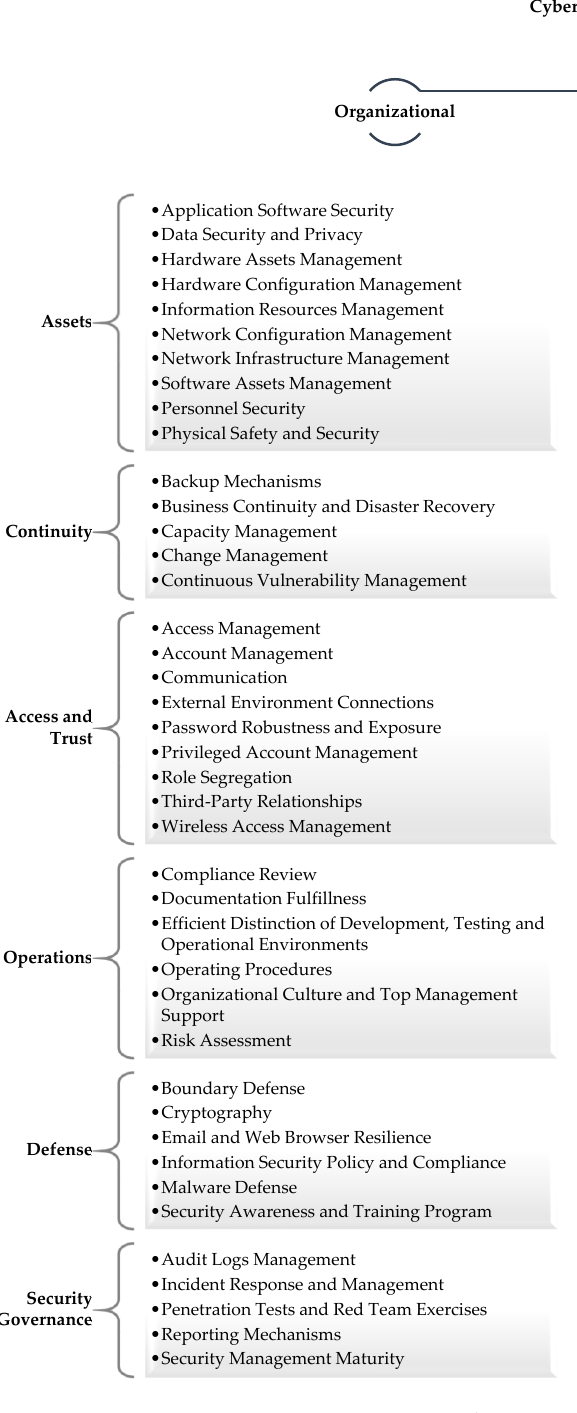
Figure 1. Cyber ‐ Security Culture Framework. Figure 1. Cyber-Security Culture